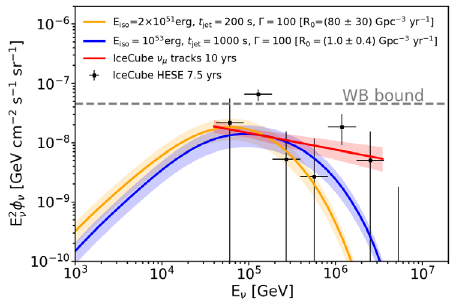
Figure 2: Di ff use neutrino spectra from choked GRBs expected on Earth, as compared with the Ice- Cube results. The blue line refers to our benchmark simulation in better agreement with IceCube data as a function of the local rate of choked GRBs. The yellow line refers to a simulation for a less luminous GRB. The dashed grey line shows the Waxmann & Bahcall upper bound